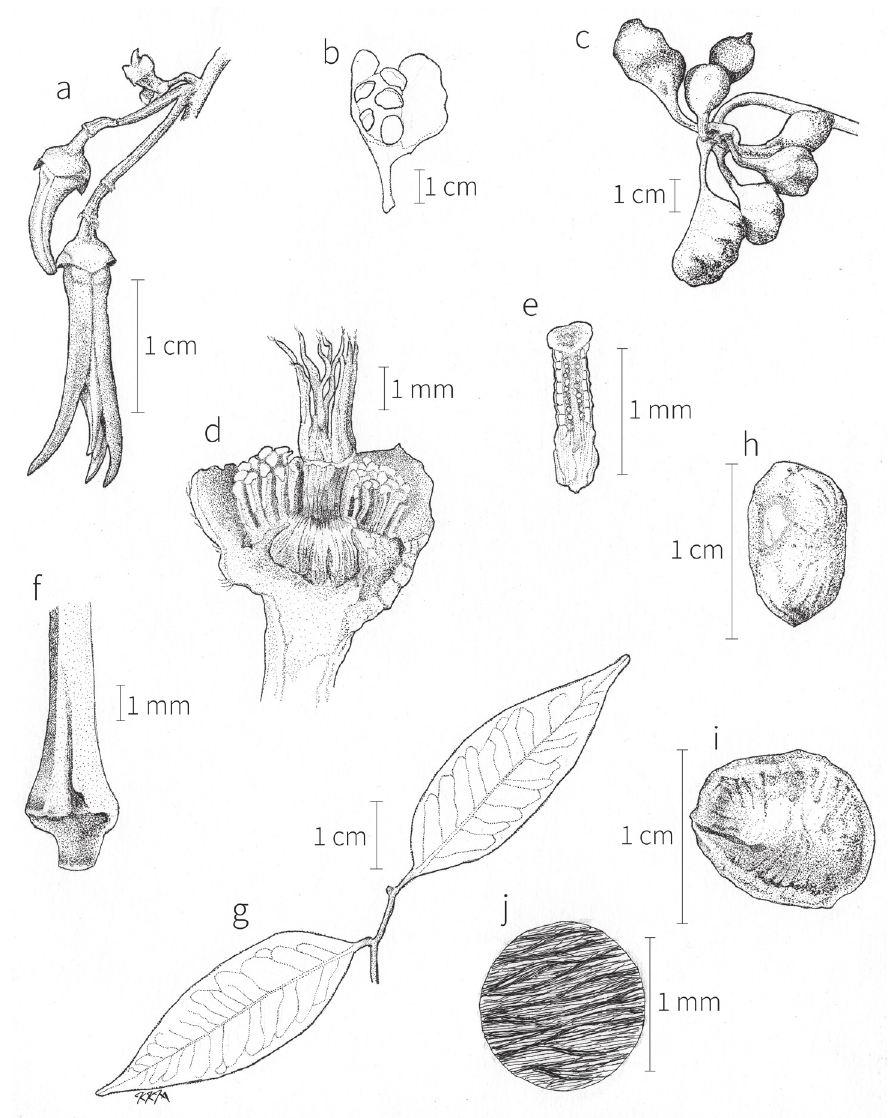
Figure 37. Xylopia cupularis . A Bud and partially open flower B Diagrammatic drawing of dehisced monocarp, showing seed arrangement C Fruit D Longitudinal section of flower with petals removed, to show the calyx, stamens attached to staminal cone, and carpels inside the cone E Stamen, abaxial view F Base of inner petal, adaxial view G Leaves H Seed, viewed from micropylar end I Seed, side view J De- tail of indument on lower leaf surface. A, D–G from Gerard 5583 (MO) B, C, H–J from Sita 4118 (P). ally not pedunculate, rarely up to 3 per peduncle, 4.5–12 mm long, 0.7–0.9 mm thick; bracts 2, both attached distal to pedicel midpoint, caducous, 1.5–1.9 mm long, semicircular, apex broadly acute to obtuse; buds linear-lanceolate, apex acute.